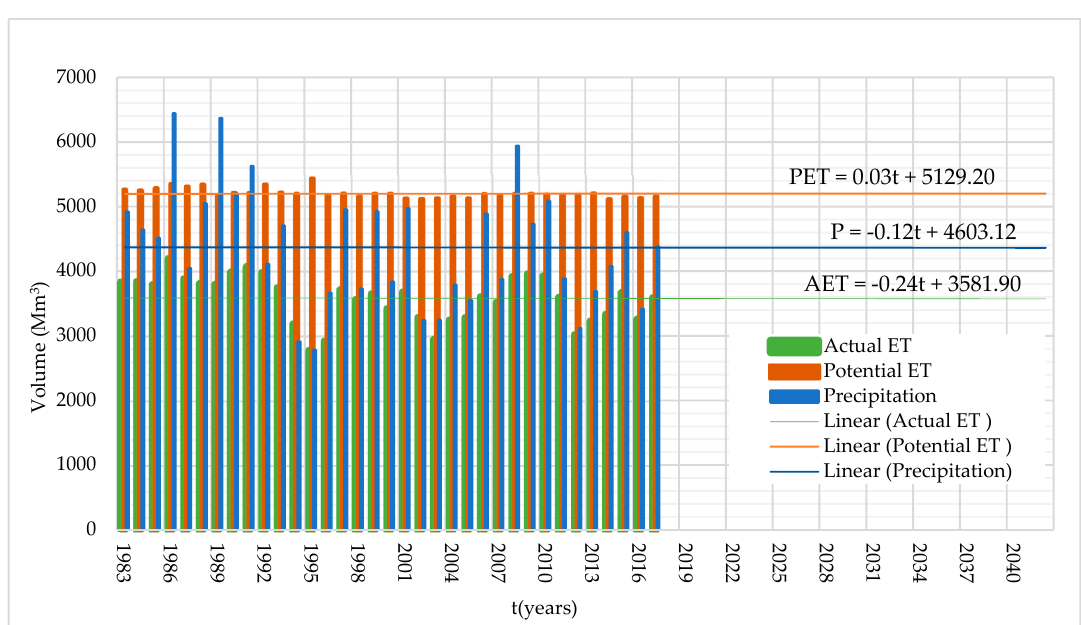
Figure 6. Annual actual evapotranspiration (ET), potential ET and precipitation for Chongwe River catchment .